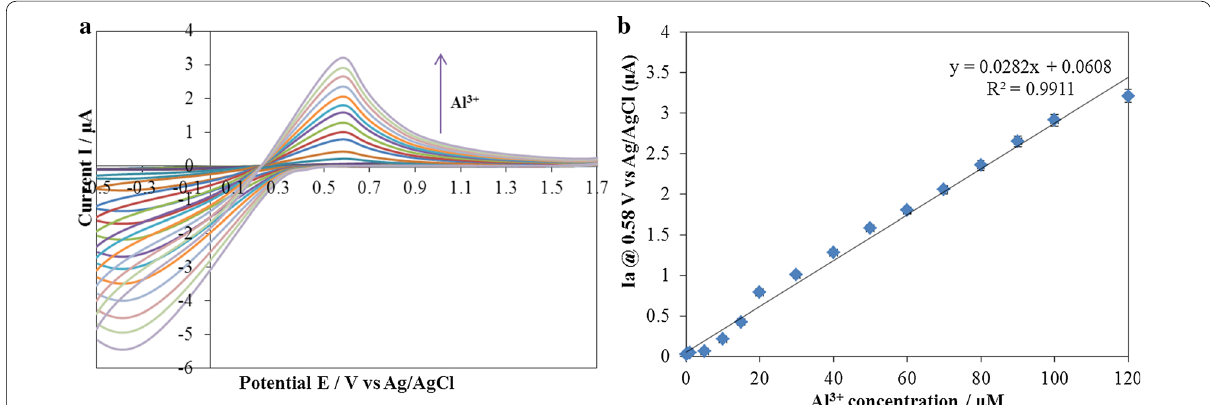
Fig. 7 a The cyclic voltammogram of ARLD-5 electrode after adding different concentrations of Al 3 + [Al 3 + concentration range 0.2–120 μM], b the peak current changes of ARLD-5 electrode with different concentrations of Al 3 +